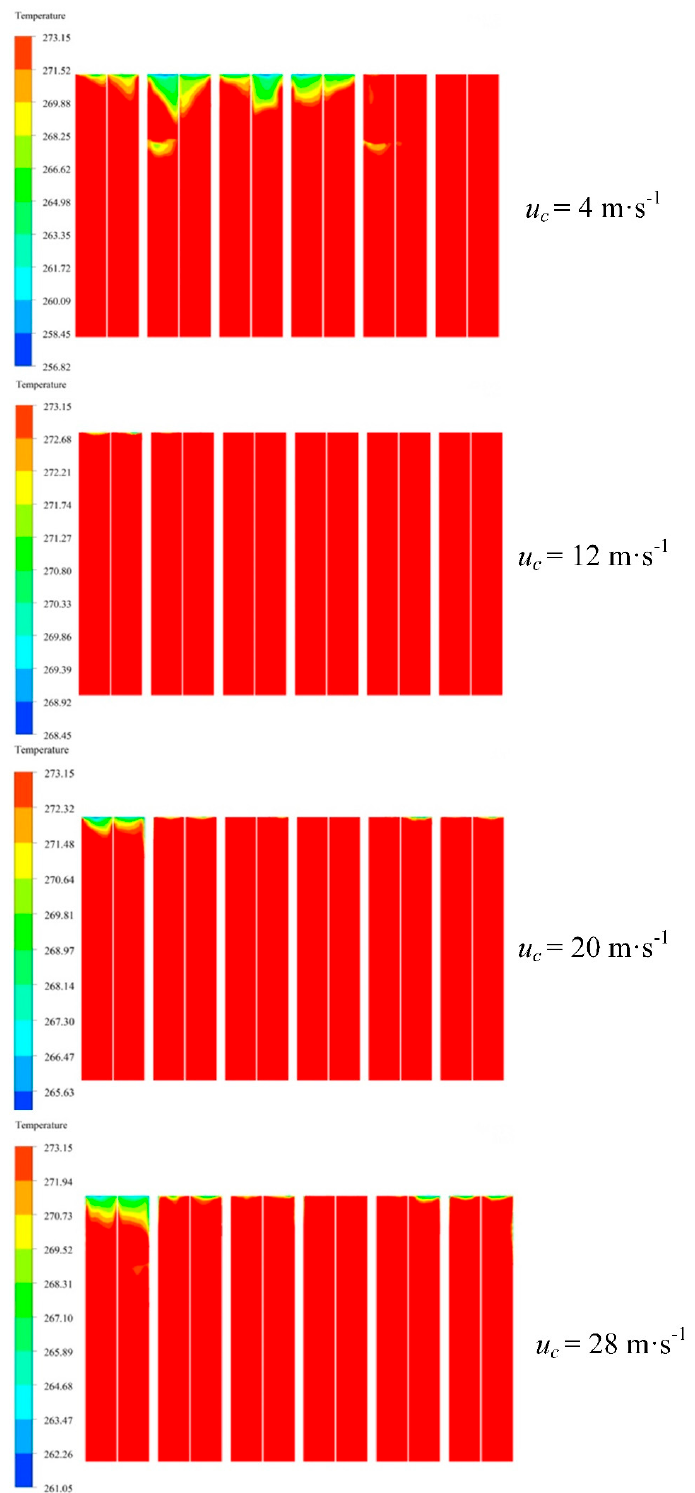
Figure 11. Temperature contours of the finned-tube radiator at various crosswind velocities. Two working conditions of crosswind with u c = 4 m·s − 1 and u c = 12 m·s − 1 were mainly compared. According to Figures 9 and 10, when the crosswind velocity was 4 m·s − 1 , airflow rates in columns 1,